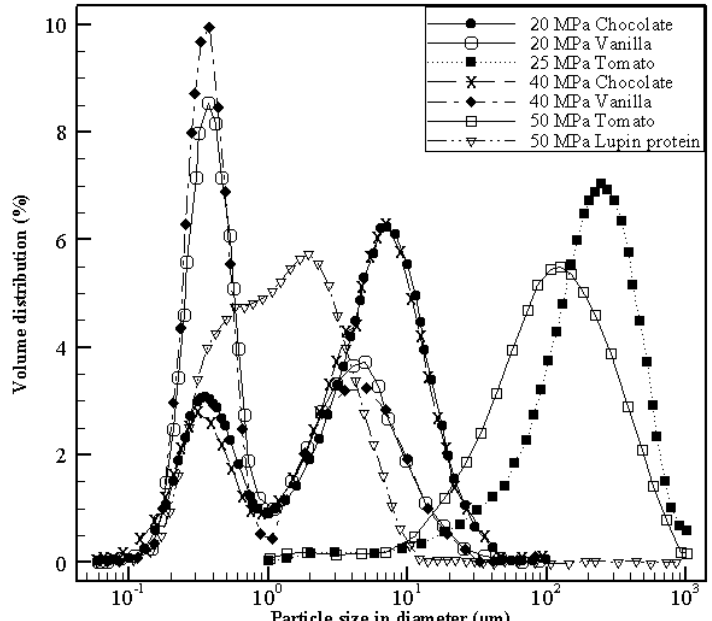
Figure 3: Particle size distribution of chocolate- and vanilla-based products, tomato and lupin protein subjected to 20-50 MPa [1, 5, 6].